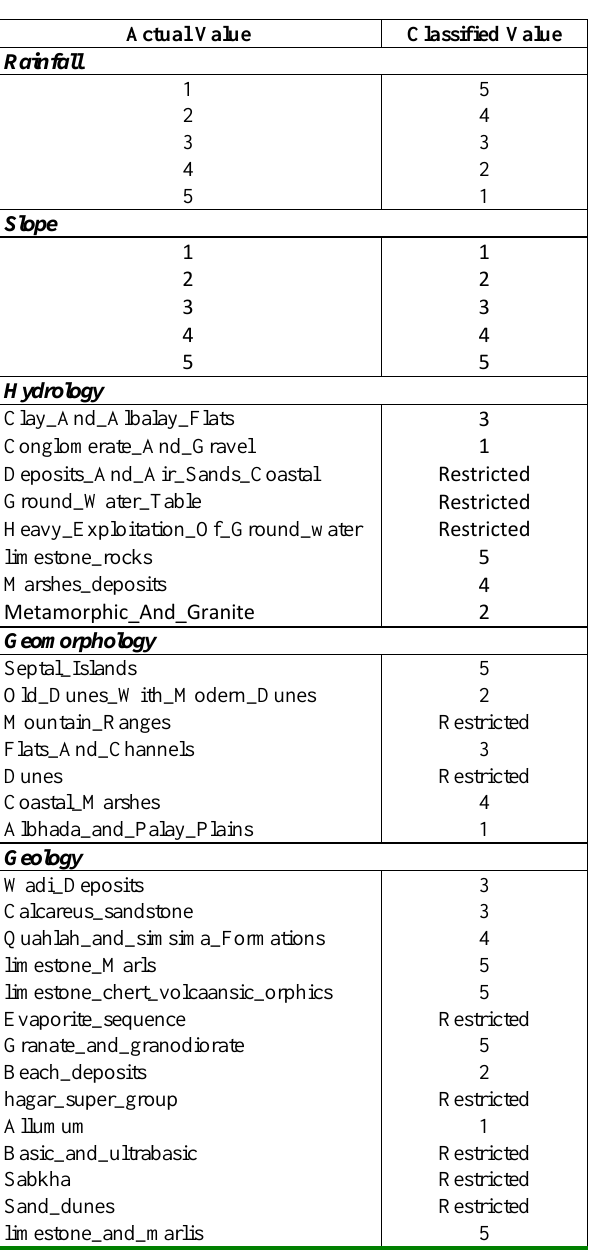
Table 2. Classification and assigned weight for each Layer.